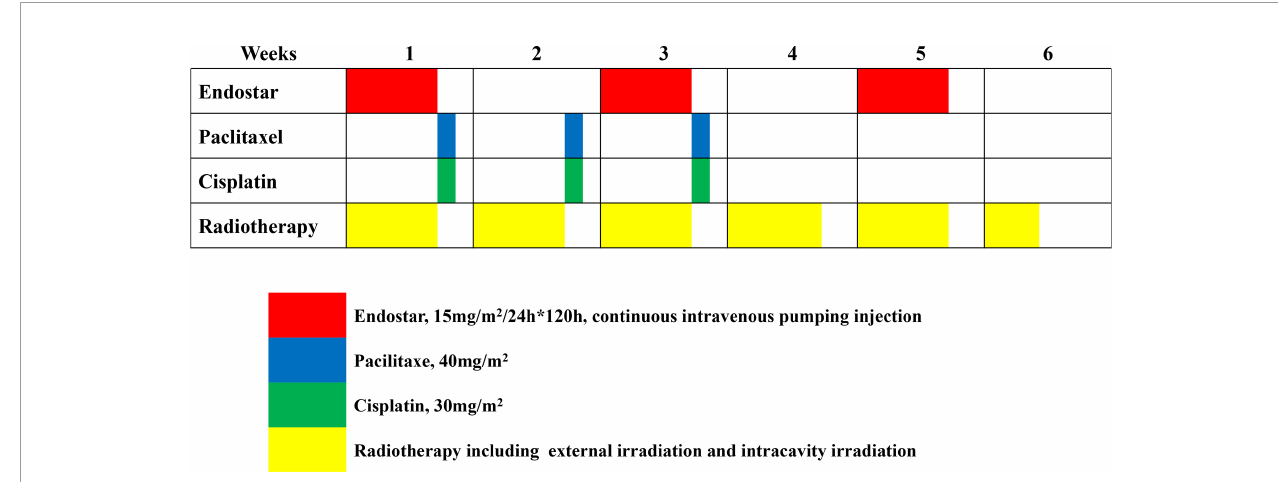
FIGURE 1 | Treatment fl